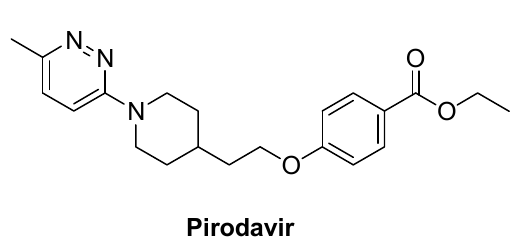
Figure 2. The chemical structure of